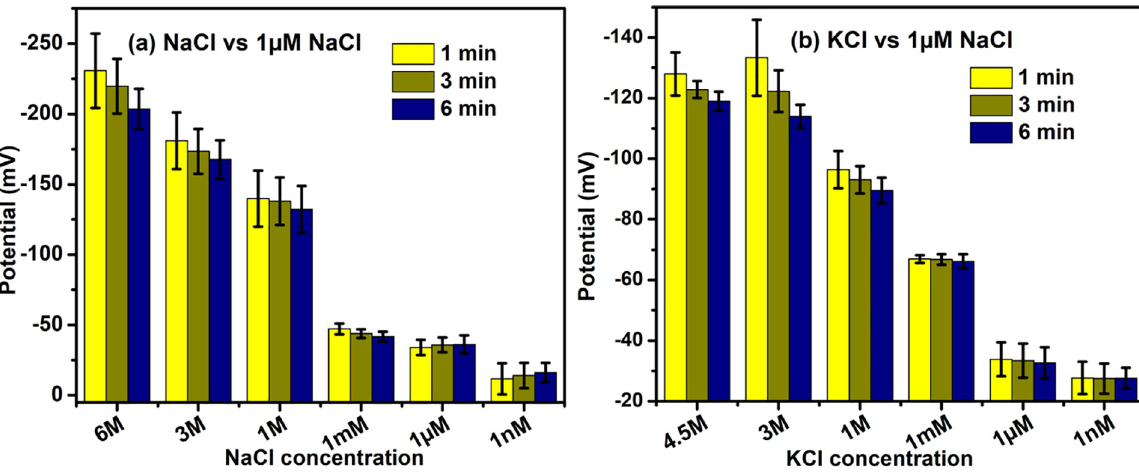
Fig 4. Potential differences between common salt solutions and DI water (containing 1 μ M NaCl). (a) NaCl solutions of different concentration in one beaker (left in Fig 1 ) were connected to the positive terminal of the voltmeter, while neutral solutions were contained in the other beaker (right in Fig 1 ), which was connected to the voltmeter’s negative terminal. (b) Experiments with KCl were arranged similarly. Stainless steel wires were used as